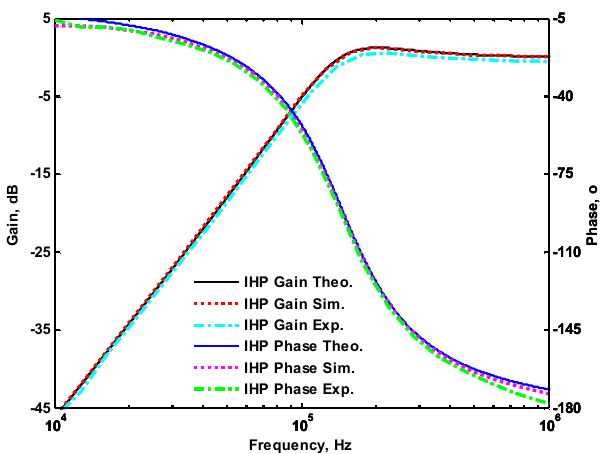
Figure 13. Experimental and simulated inverted high-pass (IHP) filters with theoretical responses in case II.